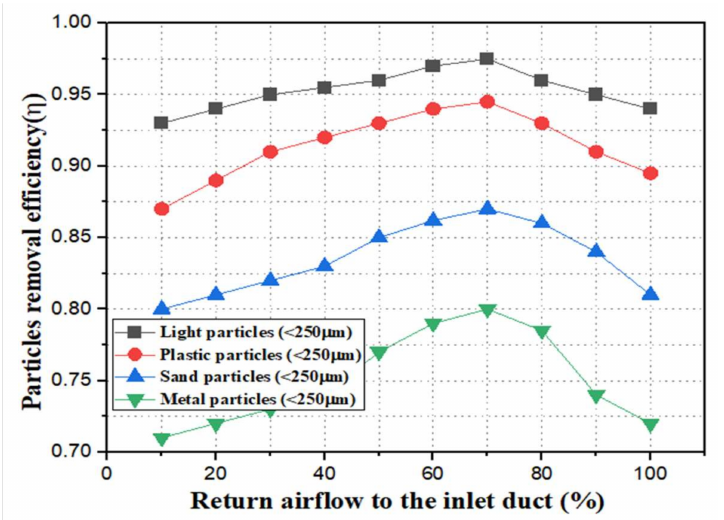
Figure 15. The results of experimental effect of the amount of flow that returns to the system on the efficiency of